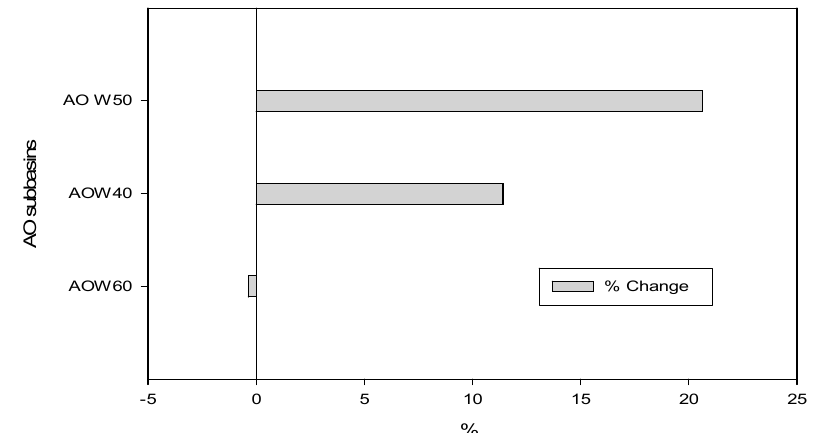
Figure 6. Sub-basin peak flow response to the Phase 1 alternative in the Andoni-Ogoni Basin. Changes in the right direction represent negative changes. It shows changes in sub-basins AO W50 and AO W40 were greater than changes in the AO W60 sub-basin. Hydrology 2019 , 6 , x FOR PEER REVIEW